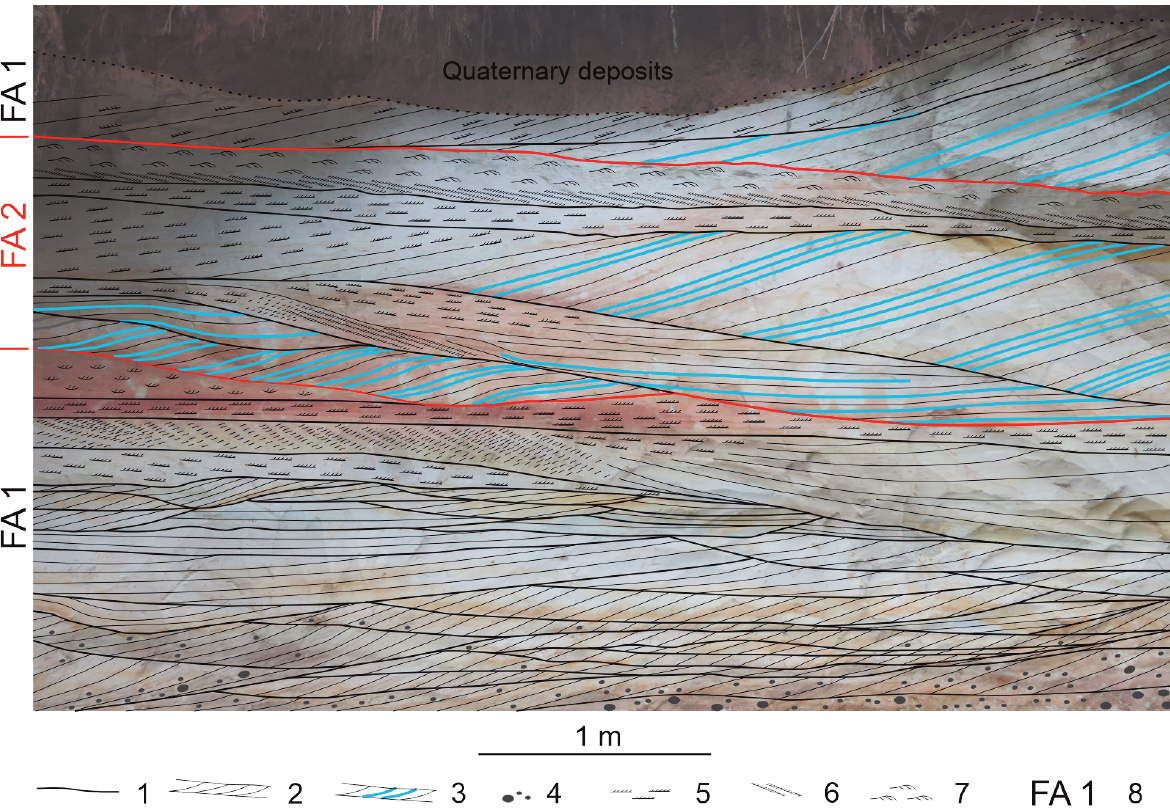
Fig. 4. Lateral tidal bar (facies association 2) bordered with deposits of facies association 1 in section 1 with dominant sedimentary structures and bedform morphology. Note the climbing cross­beds, convex­upwards surfaces of beds, as well as the changing sedimentary structures – cross­bedding to ripple­lamination – within the same beds. Legend: 1, main bedding surfaces; 2, cross­ bedding; 3, cross­bedding with tidal bundles; 4, clay clasts; 5, current ripple­lamination; 6, climbing current ripple­lamination; 7, wave ripple­lamination; 8, facies associations and their